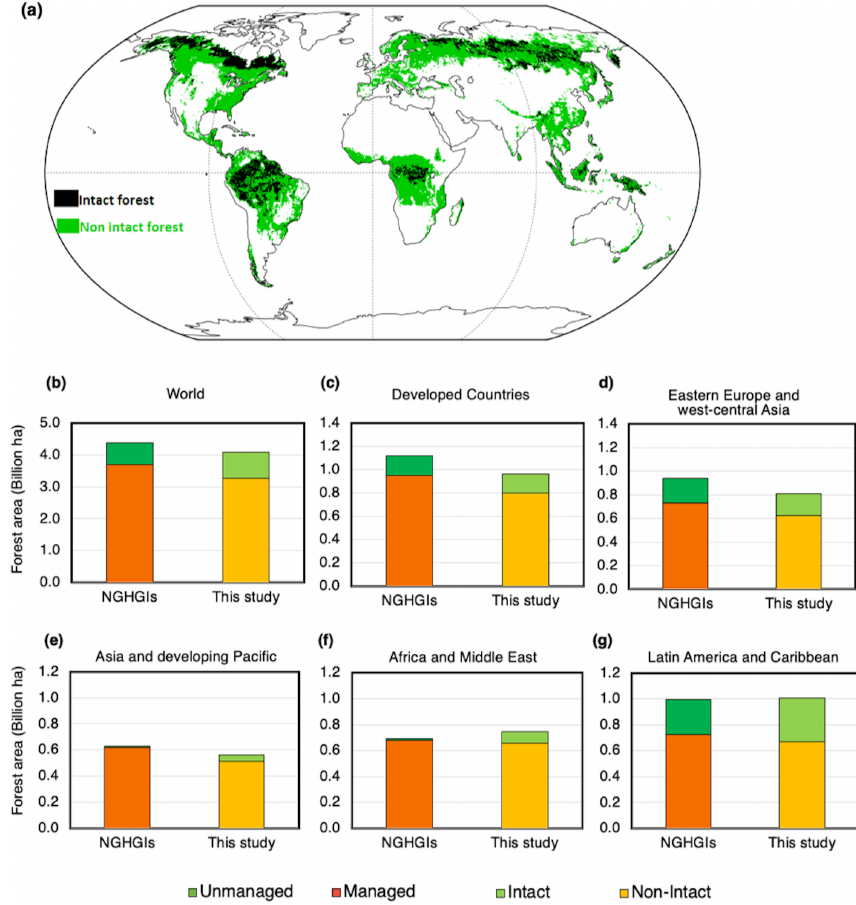
Figure 2. (a) Forest map used in this study, based on maps of intact forest (Potapov et al., 2017) and non-intact forest (total forest area from Hansen et al., 2013, minus area of intact forest), except for Canada and Brazil where the NGHGI maps of managed and unmanaged forest are used (see Methods); (b–g) statistics of managed and unmanaged forest in 2015 based on NGHGIs (Grassi et al., 2022) compared to the forest map used in this study, for the world and five macro-regions (see Table S1 and Grassi et al., 2023, for individual countries). This study uses the maps of intact and non-intact forests as a proxy for unmanaged and managed forests, respectively, except for Brazil and Canada where the country maps were available. For Russia, the tree-cover threshold from Hansen et al. (2013) was adjusted to have a better match with the regional distribution of managed forest in the